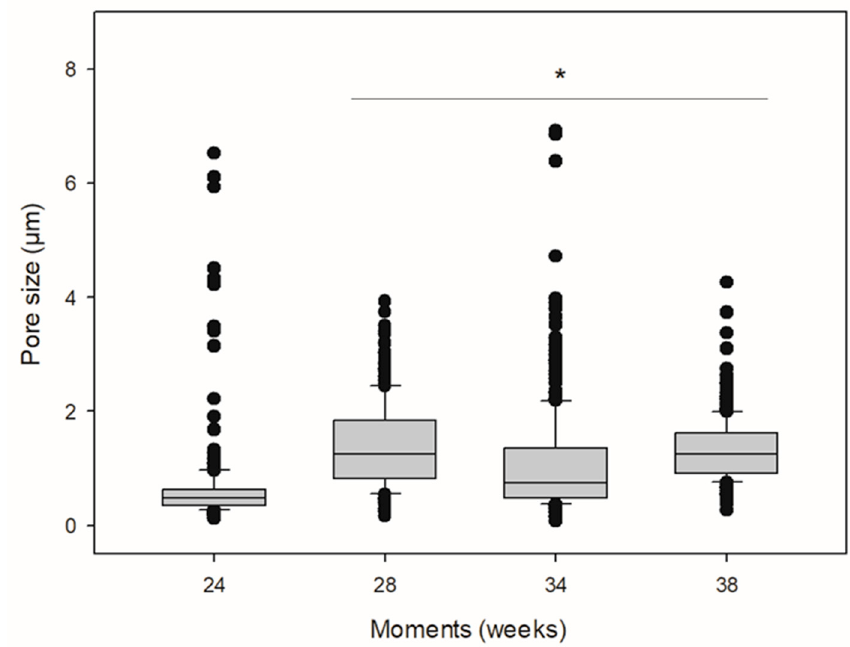
Figure 7. Medians and amplitude of pore size of PLA implanted subcutaneously in one horse. * Indicates increase in pore size when compared to pore size at 24 weeks following implantation (Kruskal-Wallis, H = 423.113; p < 0.001).